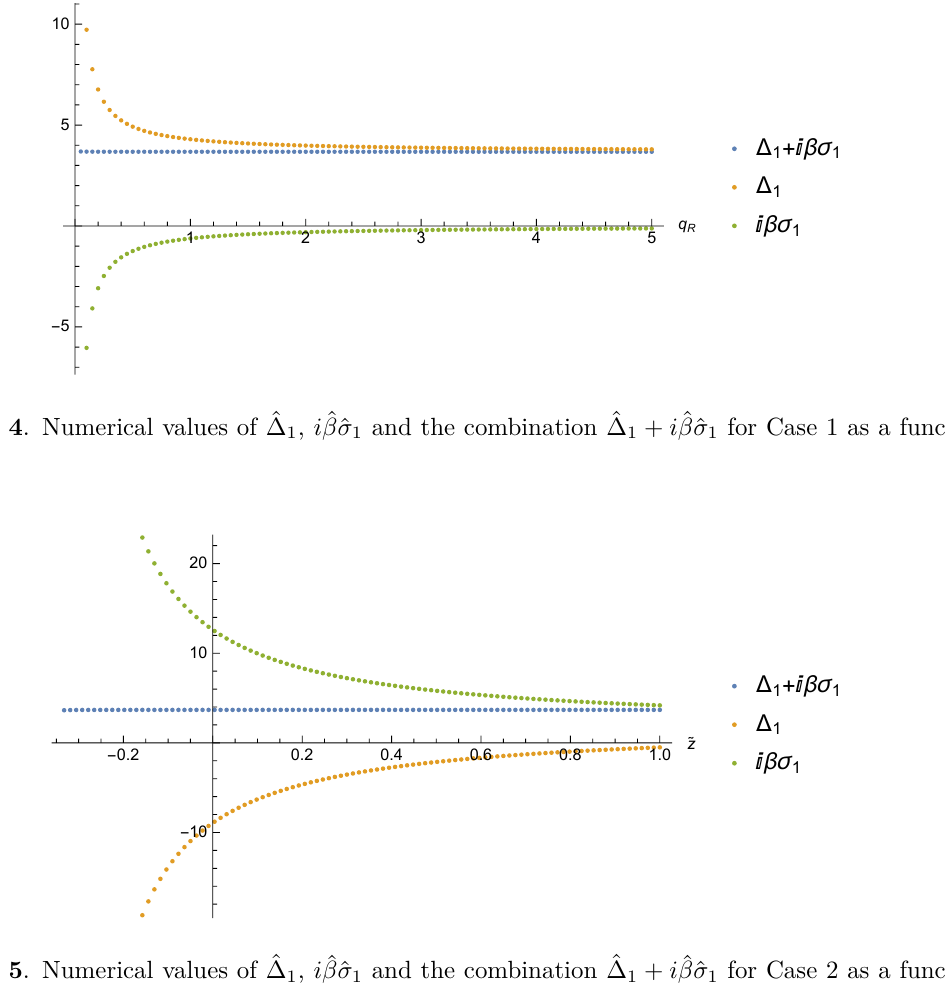
Figure 5 . Numerical values of ˆ∆ 1 , i ˆ β ˆ σ 1 and the combination ˆ∆ 1 + i ˆ β ˆ σ 1 for Case 2 as a function the IR value ˜ z (0) .